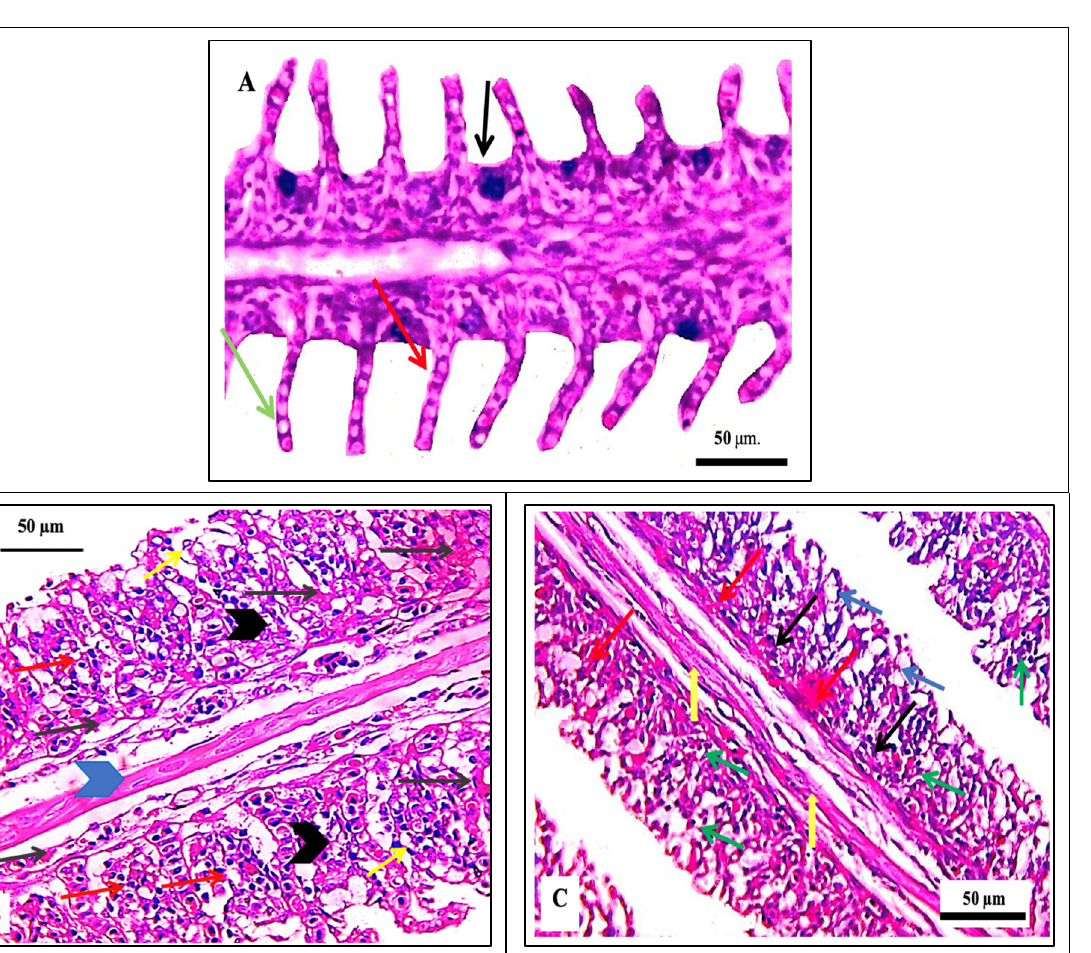
(-) not alterations found, (+) visible alterations, (++) medium alterations, and (+++) extreme altera- tions.